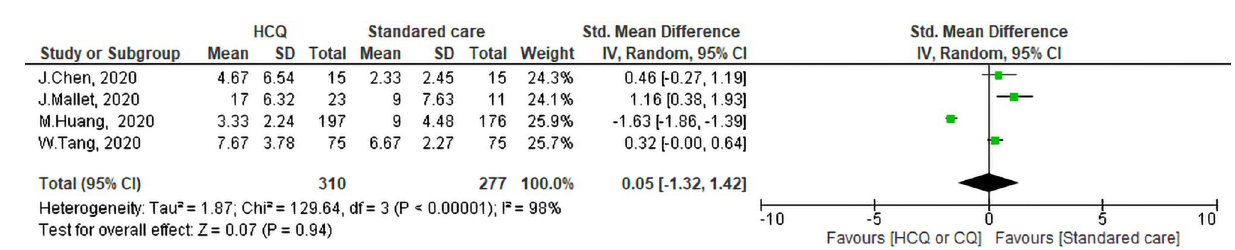
Figure 10. Forest plot for pooling std. mean differences of the time to a negative polymerase chain